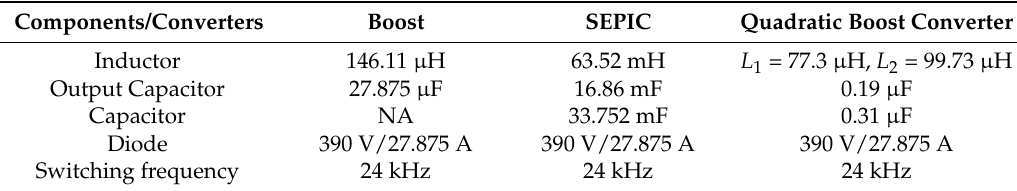
Table 2. Parameters of boost, sepic and quadratic boost